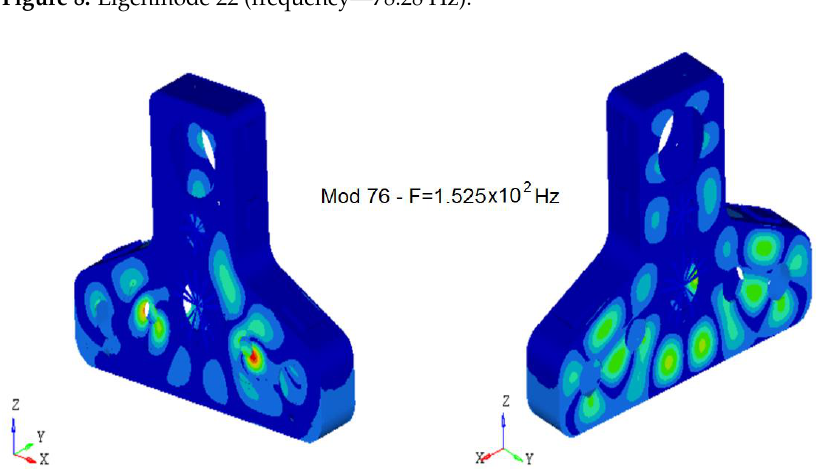
Figure 9. Eigenmode 76 (frequency — 1525.78 Hz).